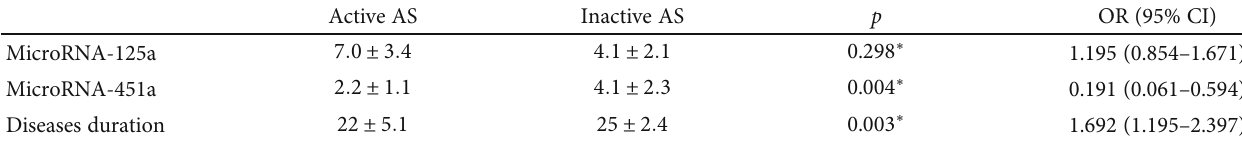
Table 4: Univariate and multivariate analyses for the parameters a ff ecting active